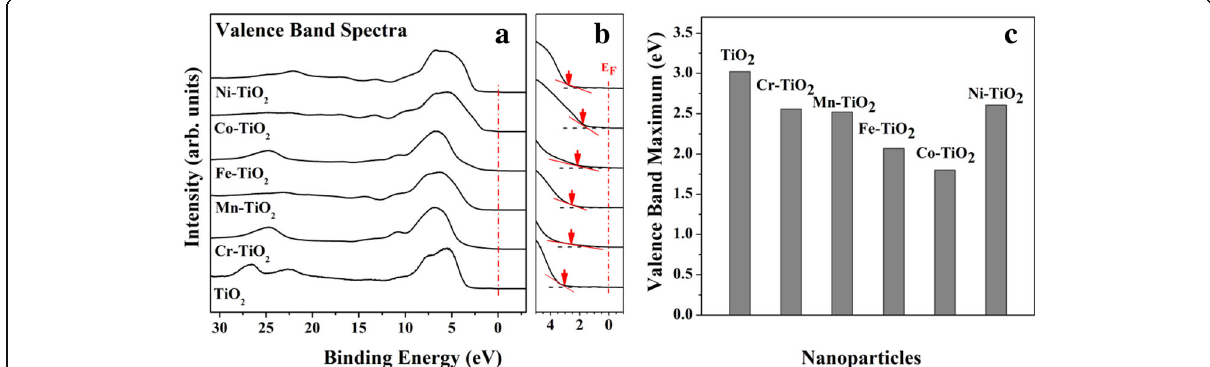
Fig. 4 a Valence spectra and b magnified view of valence band edge of anatase TiO 2 and the five TM-TiO 2 . c The plot of valence band maximum values of